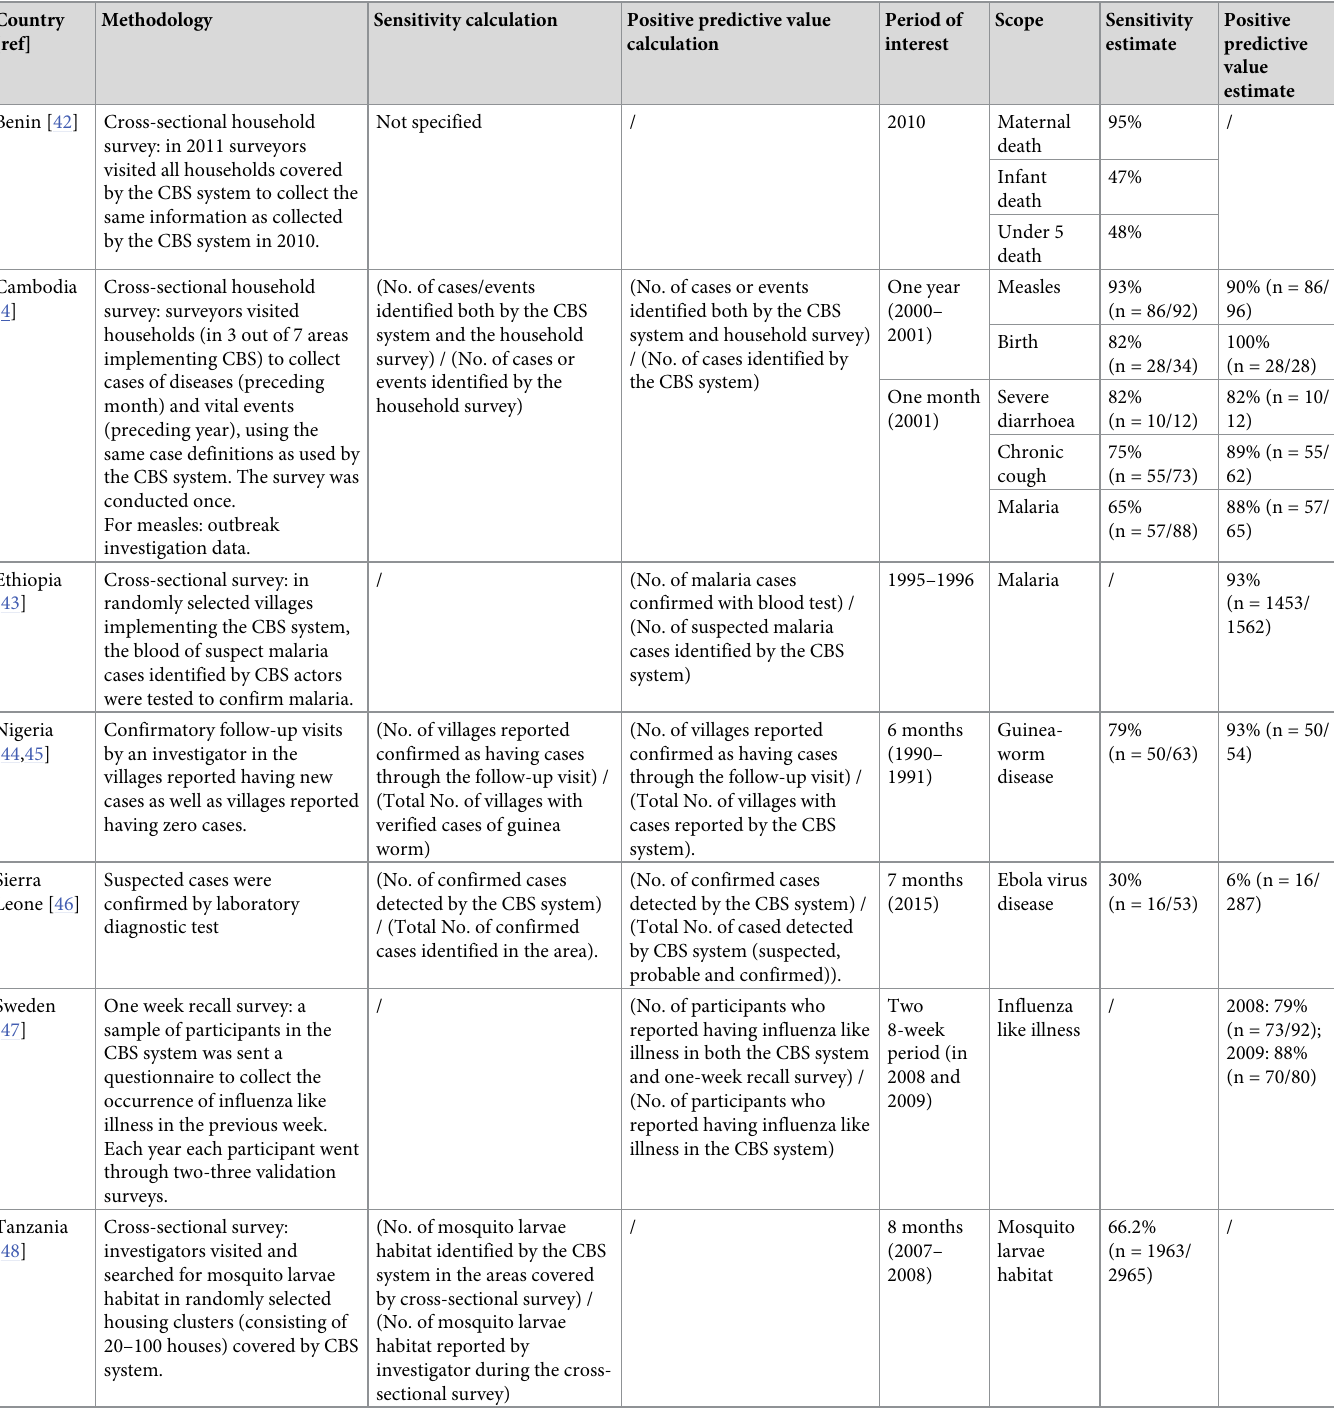
Table 3. Estimates of the sensitivity and positive predictive value of CBS